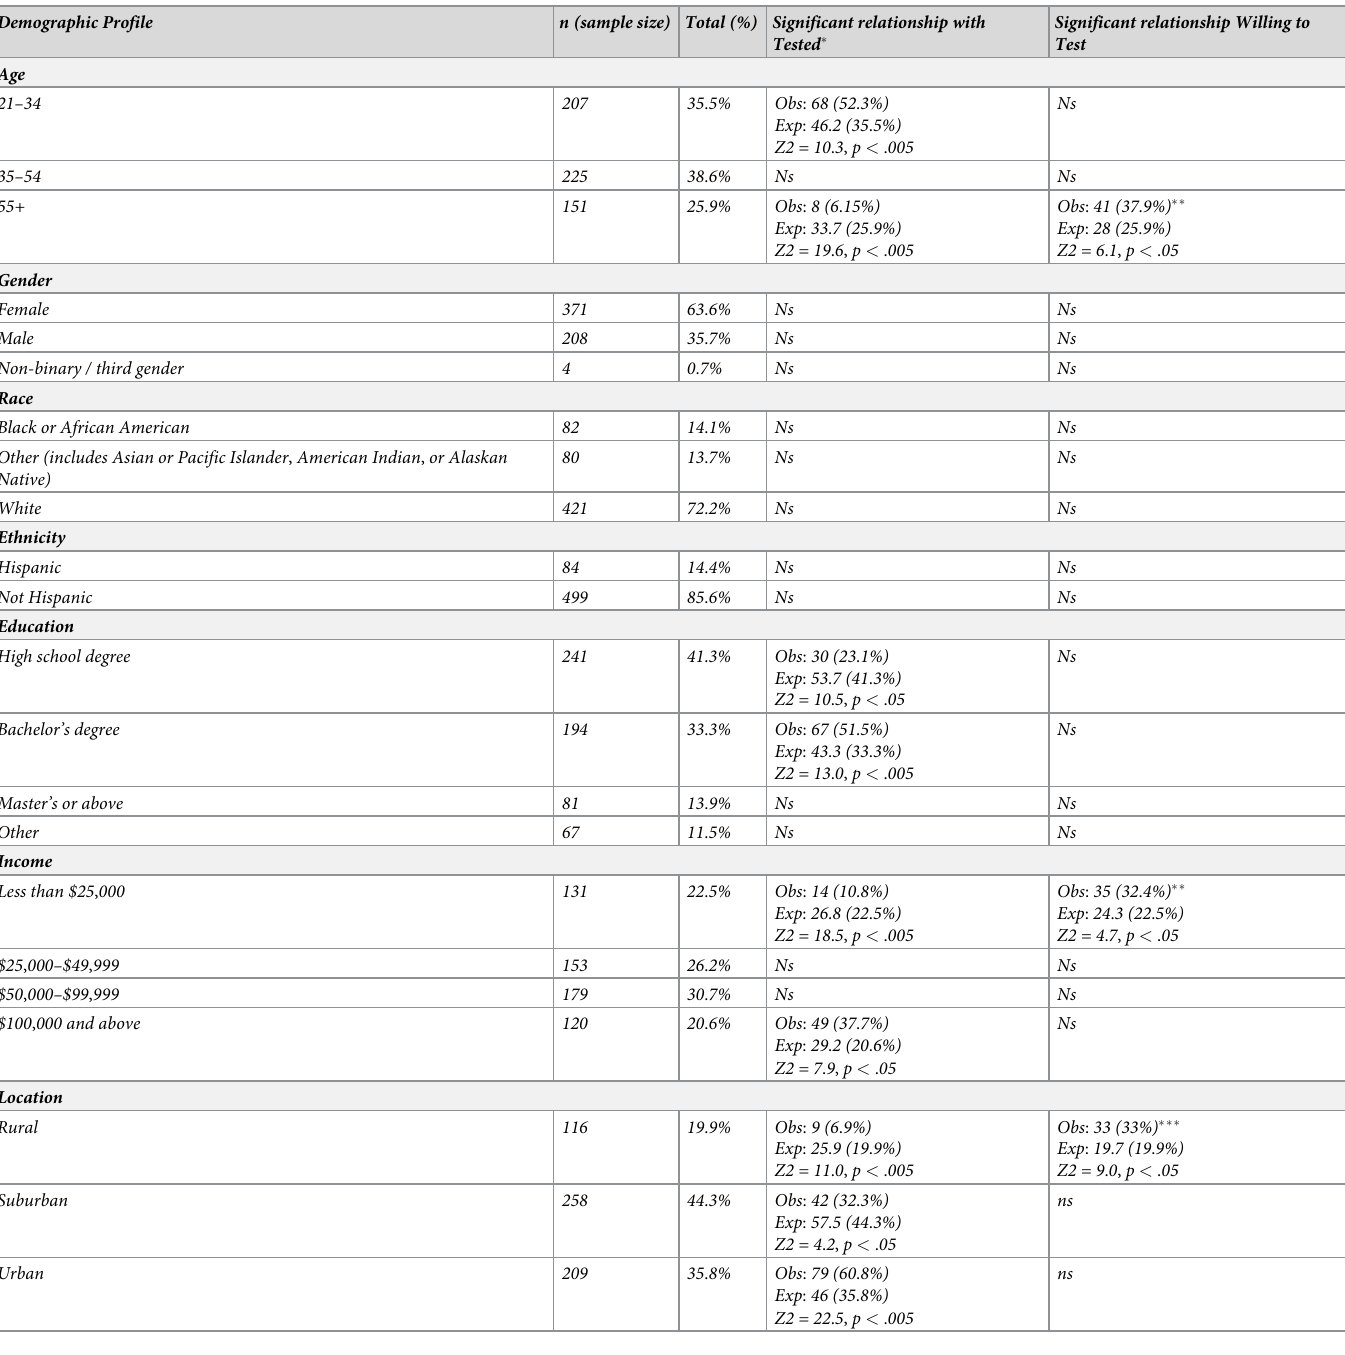
Table 3. Participant demographic profile information and significant relationships with testing and willingness to